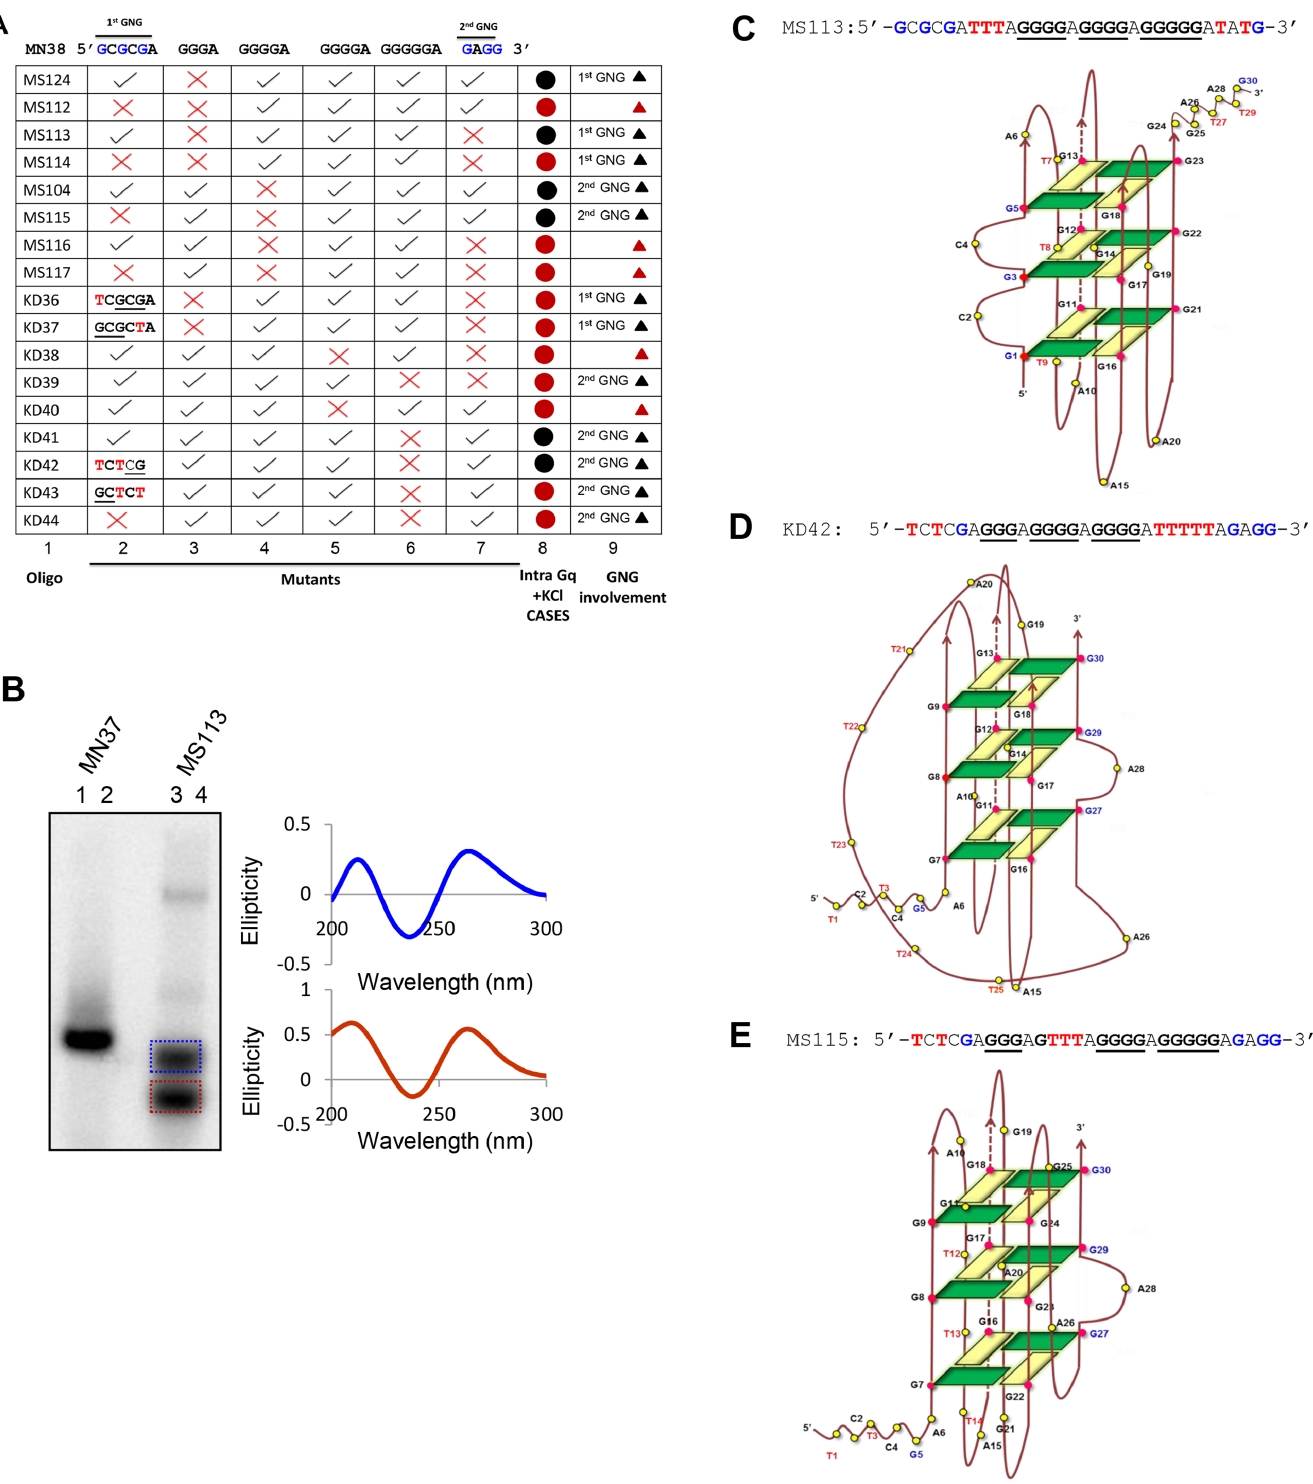
Fig 5. Summary of oligomeric DNA studied that support intramolecular G-quadruplex formation using GNG motifs and cartoon showing 2-D models of potential G-quadruplex structures. (A) Summary of oligomeric DNA of HOX11 region I, and its mutants used in the study and their potential to fold into intramolecular G-quadruplex using GNG motifs. The red cross (from 2 nd to 7 th column) represents alterations in the DNA sequence and the black ‘ tick mark ’ represents no change in sequence. The red circle in the 8 th column indicates no formation of intramolecular G-qudraplex involving